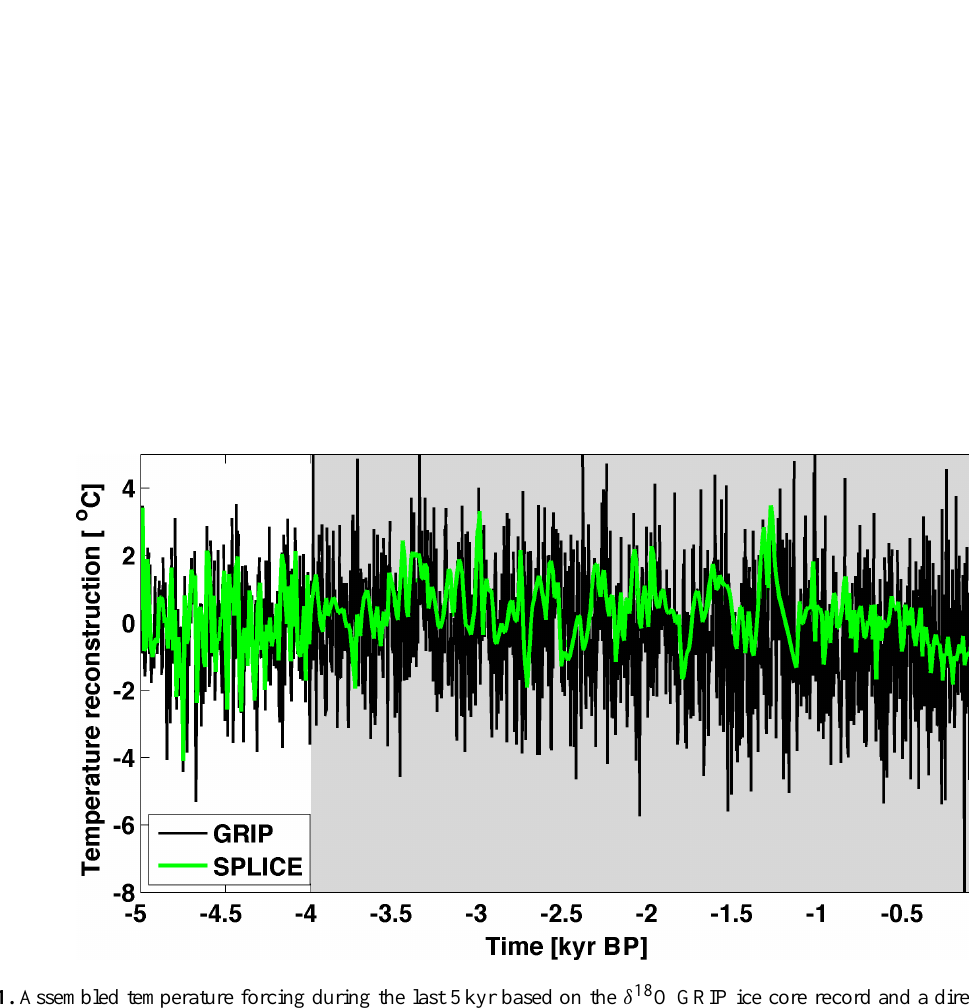
Figure A1. Assembled temperature forcing during the last 5kyr based on the δ 18 O GRIP ice core record and a direct temperature recon- struction. The splicing point of these two records is indicated by a change in the background shading at 4kyrBP. Note that the original GRIP record shows sub-decadal resolution during the Holocene period while the temperature forcing, used here, is linearly interpolated for a decadal sampling